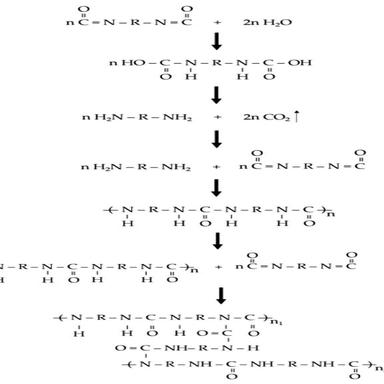
The chemical reaction process of diisocyanate with water.